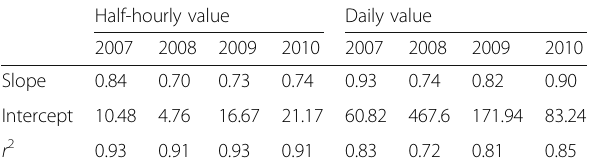
Table 2 Energy enclosure based on half-hourly and daily